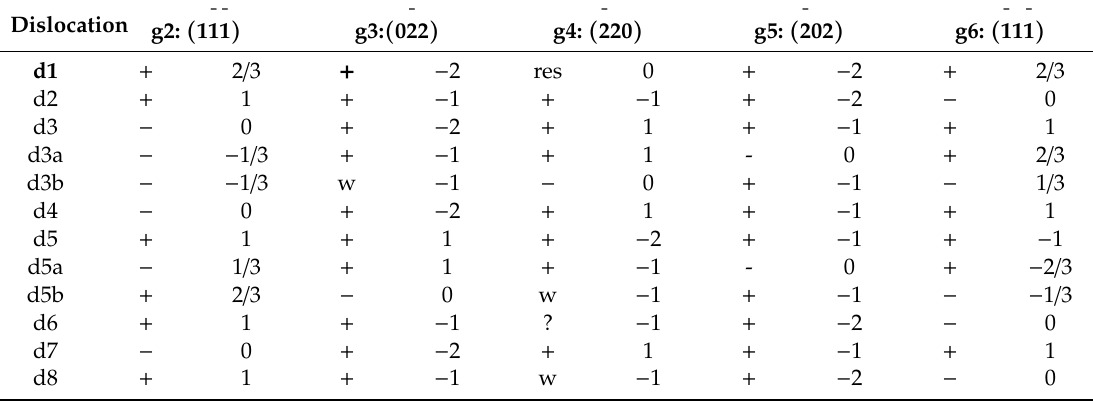
Table 3. E ff ective visibilities ( + ) and invisibilities (-) for g -vectors 2 to 6 from Table